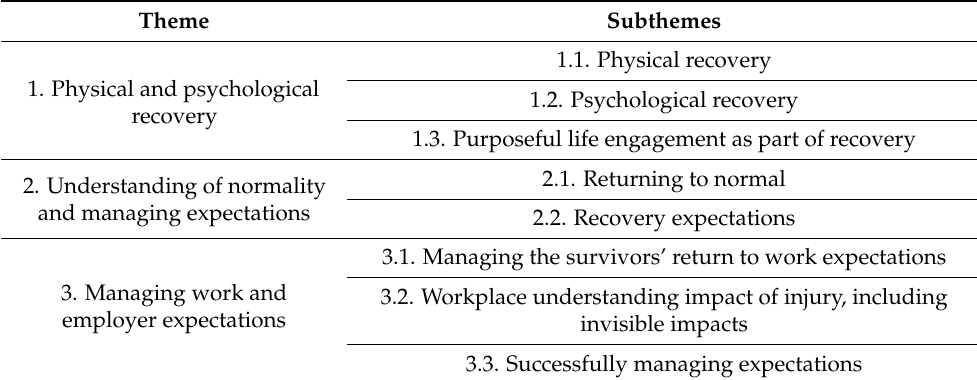
Table 2. Study 2 themes and